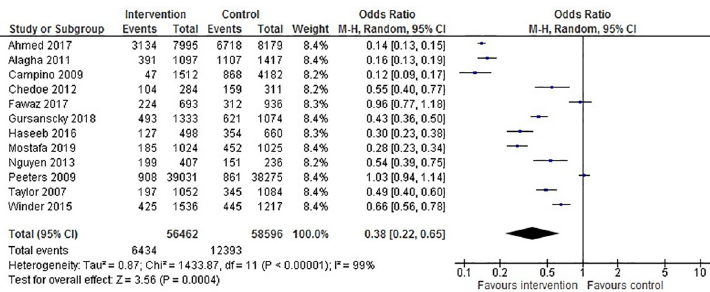
Fig 2. Random effect model of pharmacist-led education and its association with medication errors.